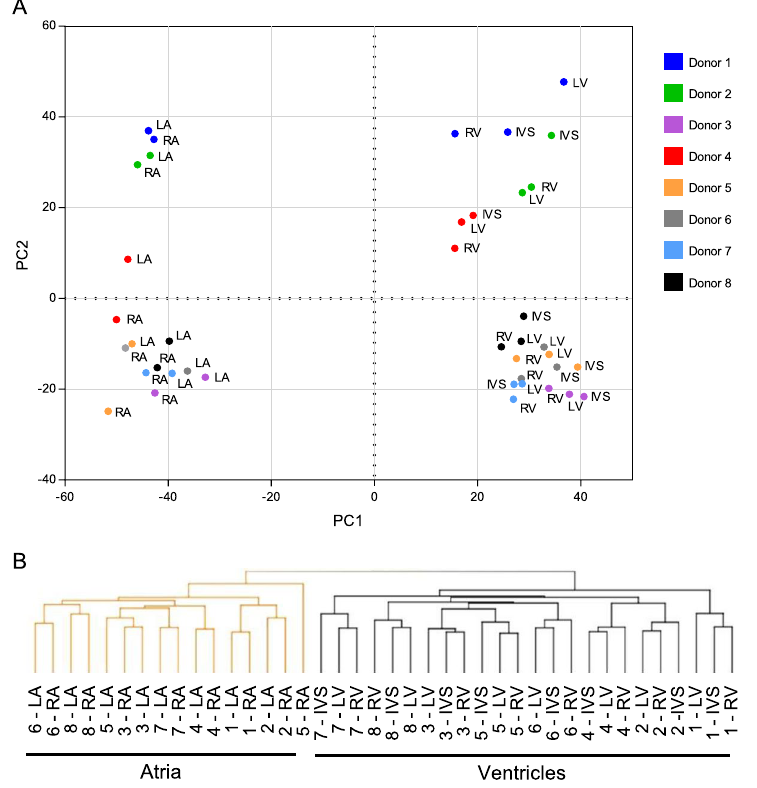
Figure 4. Long non-coding RNAs expression profiles in non-failing human atria and ventricles are distinct. ( A ) Principal component analyses of normalized read counts in all cardiac expressed lncRNA transcripts distinguish the atrial and ventricular samples. The LA and RA samples and, separately, the LV, RV and IVS samples cluster by donor. ( B ) Unsupervised hierarchical clustering of the expression profiles of human cardiac lncRNAs also distinguish the atrial (orange), from the ventricular (black), samples. These analyses further clustered the LA and RA samples, as well as the LV, RV and IVS samples, by donor (see